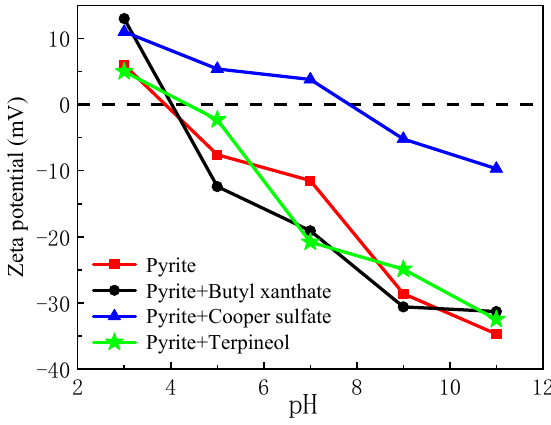
Figure 5. Zeta potential of pyrite particles as a function of pH.